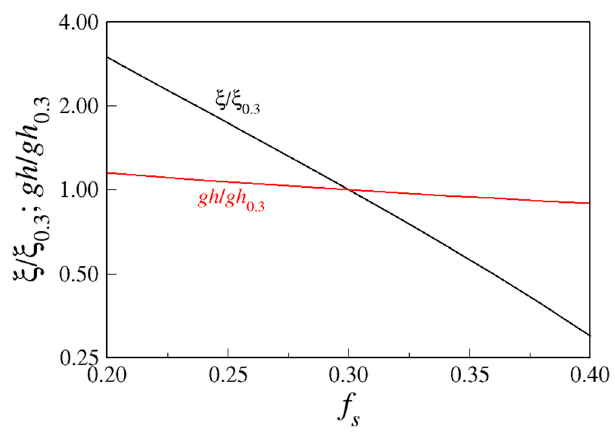
Figure 5. Contributions to the volumetric Ostwald ripening rate (at the temperature where hK (T) has its maximum) plotted against sucrose mass fraction, f s . Values are normalised relative to their value at f s = 0.3.